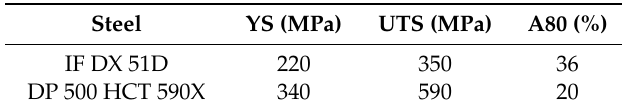
Table 2. Mechanical properties of as-received steels.